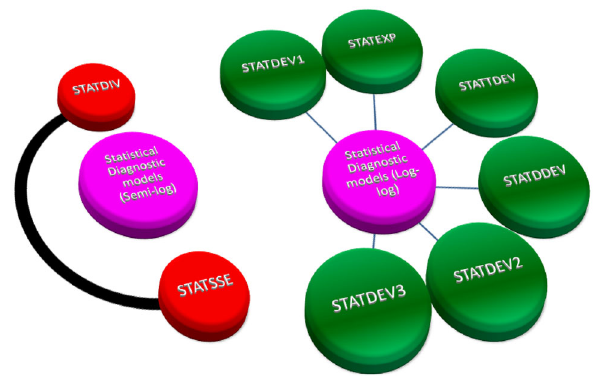
Fig. 1 Summary of statistical models for flow regime